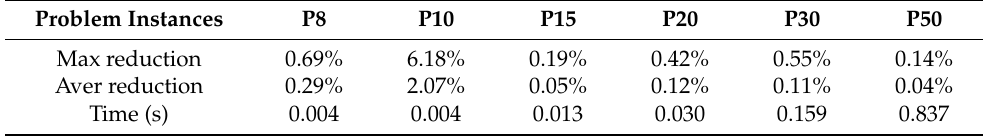
Table 5. The maximal and average of the reduction and average runtime of EA.